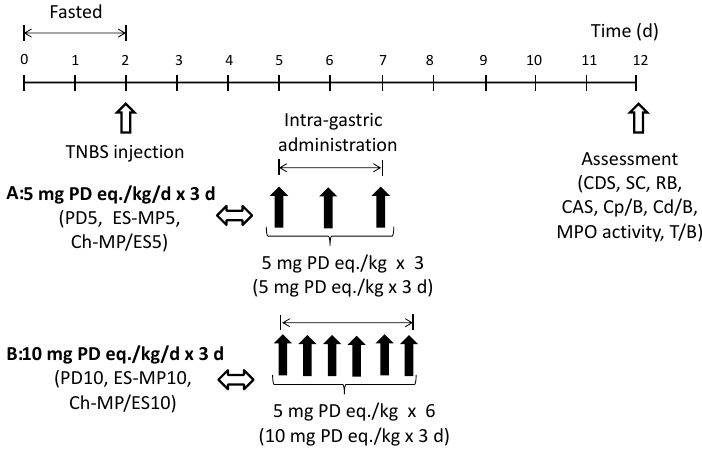
Figure 6. Schedules of studies of efficacy and toxic side effect in rats with TNBS-induced